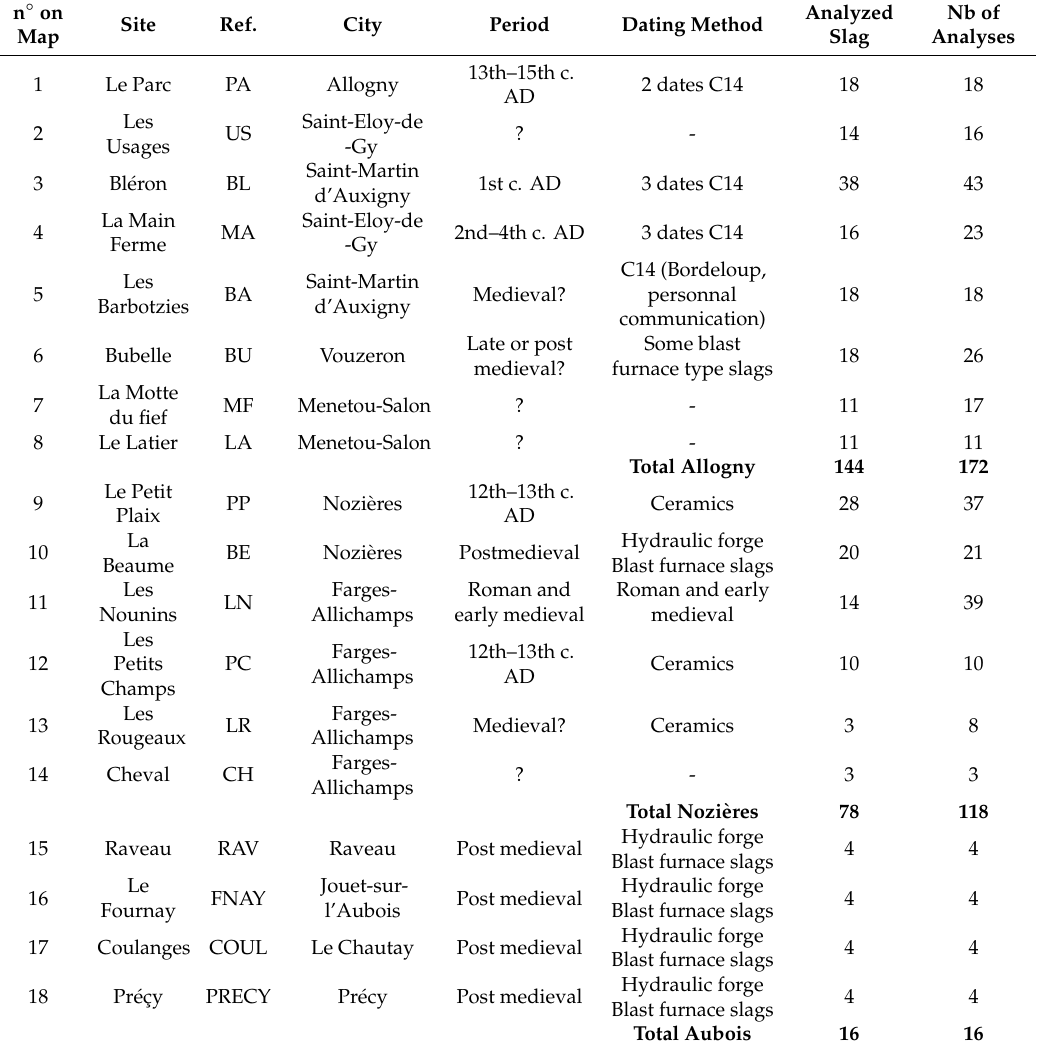
Figure 3. Welding line observed on TN3 tie-rod. Table 3. Site and slag studied Table 1. Samples of the iron chain.